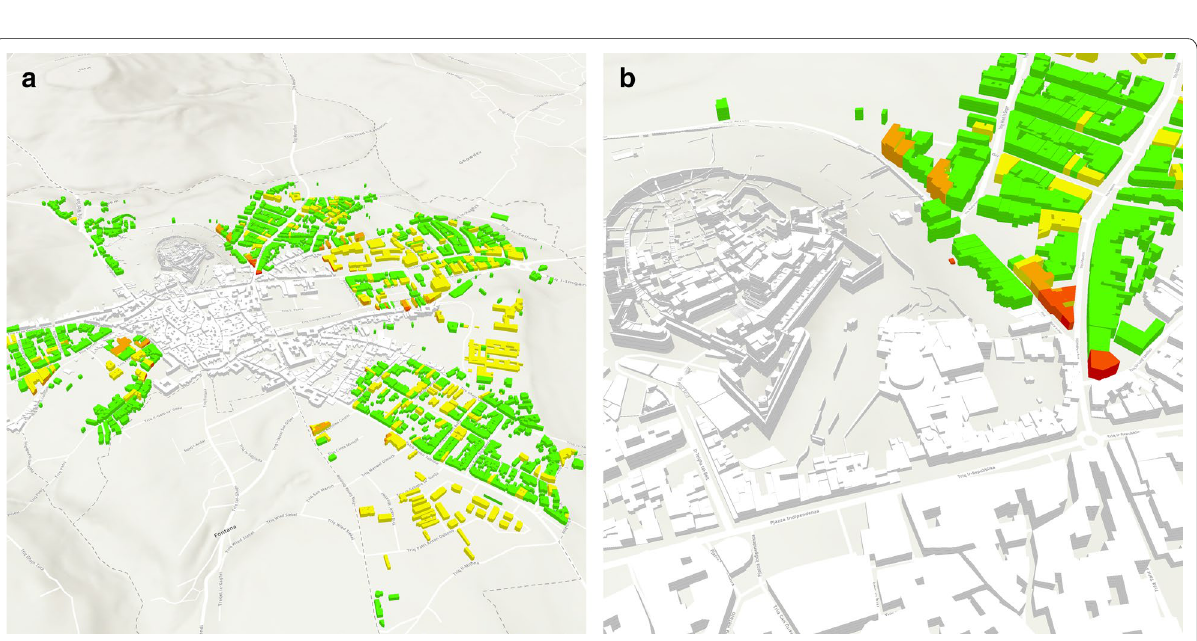
buildings) are stored, which return the visibility values For Victoria, in fact, the outputs of the visibility anal- in terms of “percentage of visible area”. In practice, these ysis are multipatch panels (10 10), or a type of reticu- × 10 10 multipatch panels (size in line with the size of the lar geometry in which 3D objects (in this case the ×